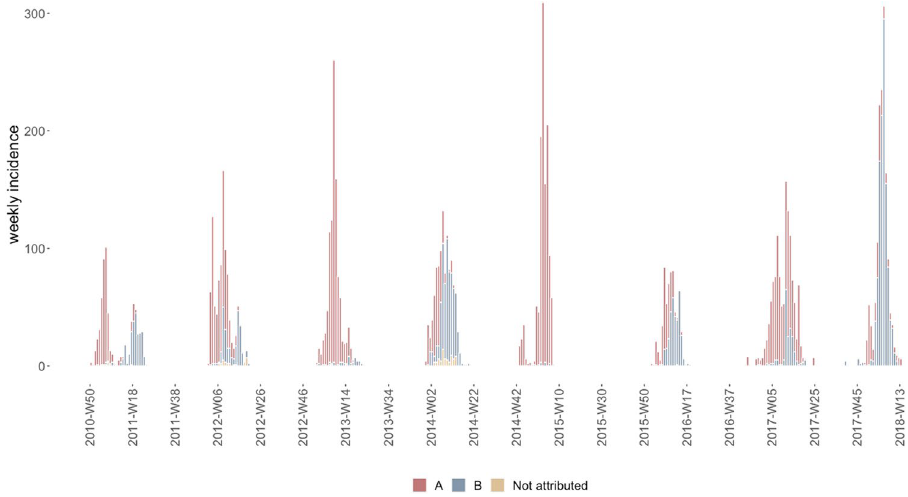
Figure 2. Weekly incidence of RDT-confirmed influenza cases in Kamigoto Island, Japan 2010/11–2017/18 influenza seasons.